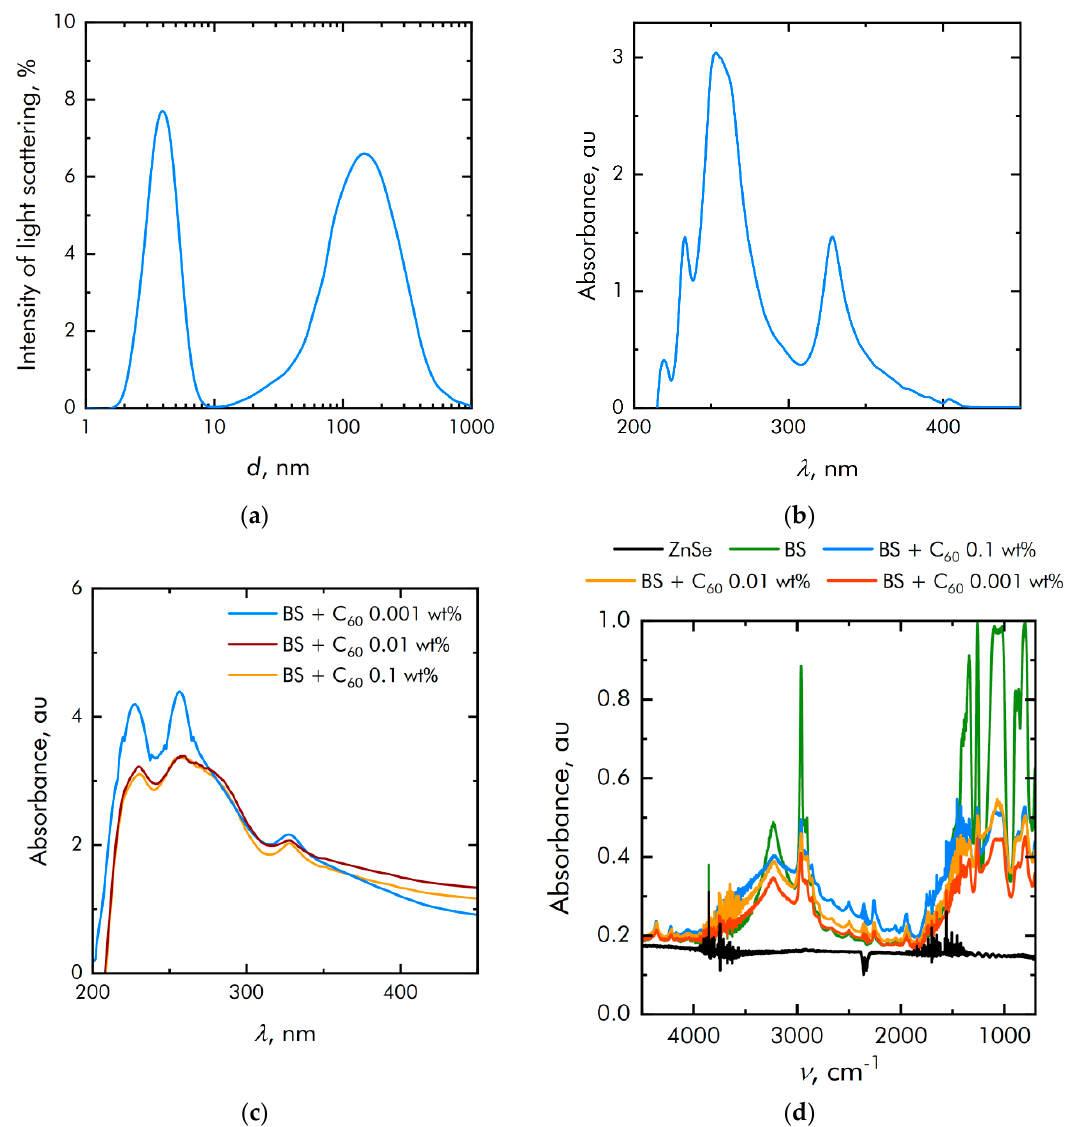
Figure 3. Physicochemical properties of fullerenes: ( a ) Particle size distribution of fullerenes; ( b ) Optical absorption of a colloidal solution of fullerenes; ( c ) Optical absorption of a colloidal solution of BS + fullerenes; ( d ) Characterization of the obtained polymers by FTIR methods.